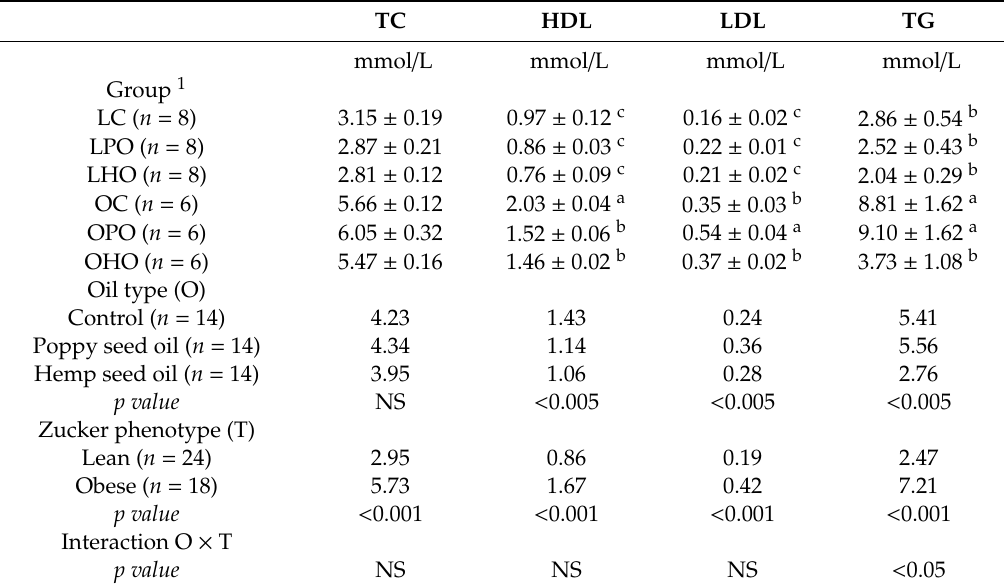
Table 2. Plasma lipid profile of rats fed experimental